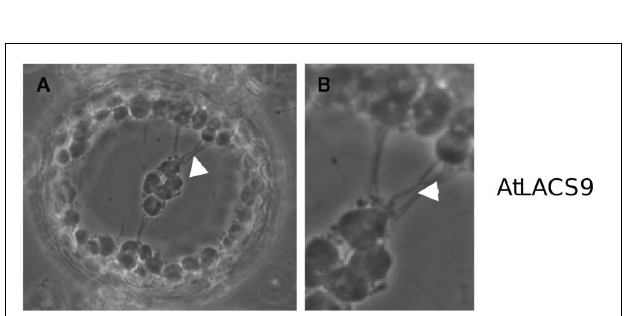
FIGURE 7 |AtLACS9 w/o GFP expression in N. benthamiana leaf protoplast. Protoplast of a transfected N. benthamiana leaf cell expressing AtLACS9 driven by a 35S-promoter. (A) Chloroplasts are connected by a system of strings (arrowhead). (B) Close-up of the connections between the chloroplasts.